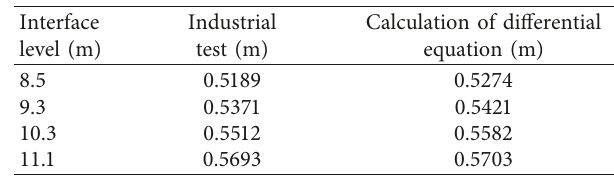
Table 5: Underflow results of industrial test and calculation of differential